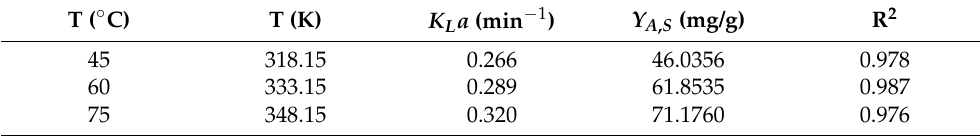
Figure 3. Extraction kinetics at different temperatures: model prediction versus experimental data at 45 °C (Δ), 60 °C (o), and 75 °C (□). Table 4. Estimated 𝐾 𝐿 𝑎 values, equilibrium yields, and correlation coefficients at different temper- atures.